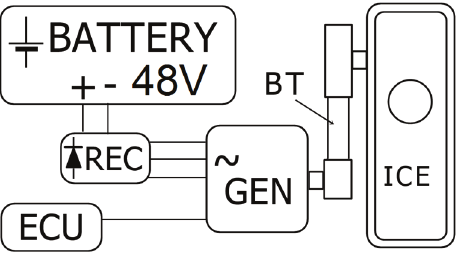
Fig. 2. Adopted concept of the range extender; ICE – Internal Combustion Engine, BT – Belt Transmission, GEN – Generator, REC – Rectifier Bridge, ECU – Electronic Control Unit